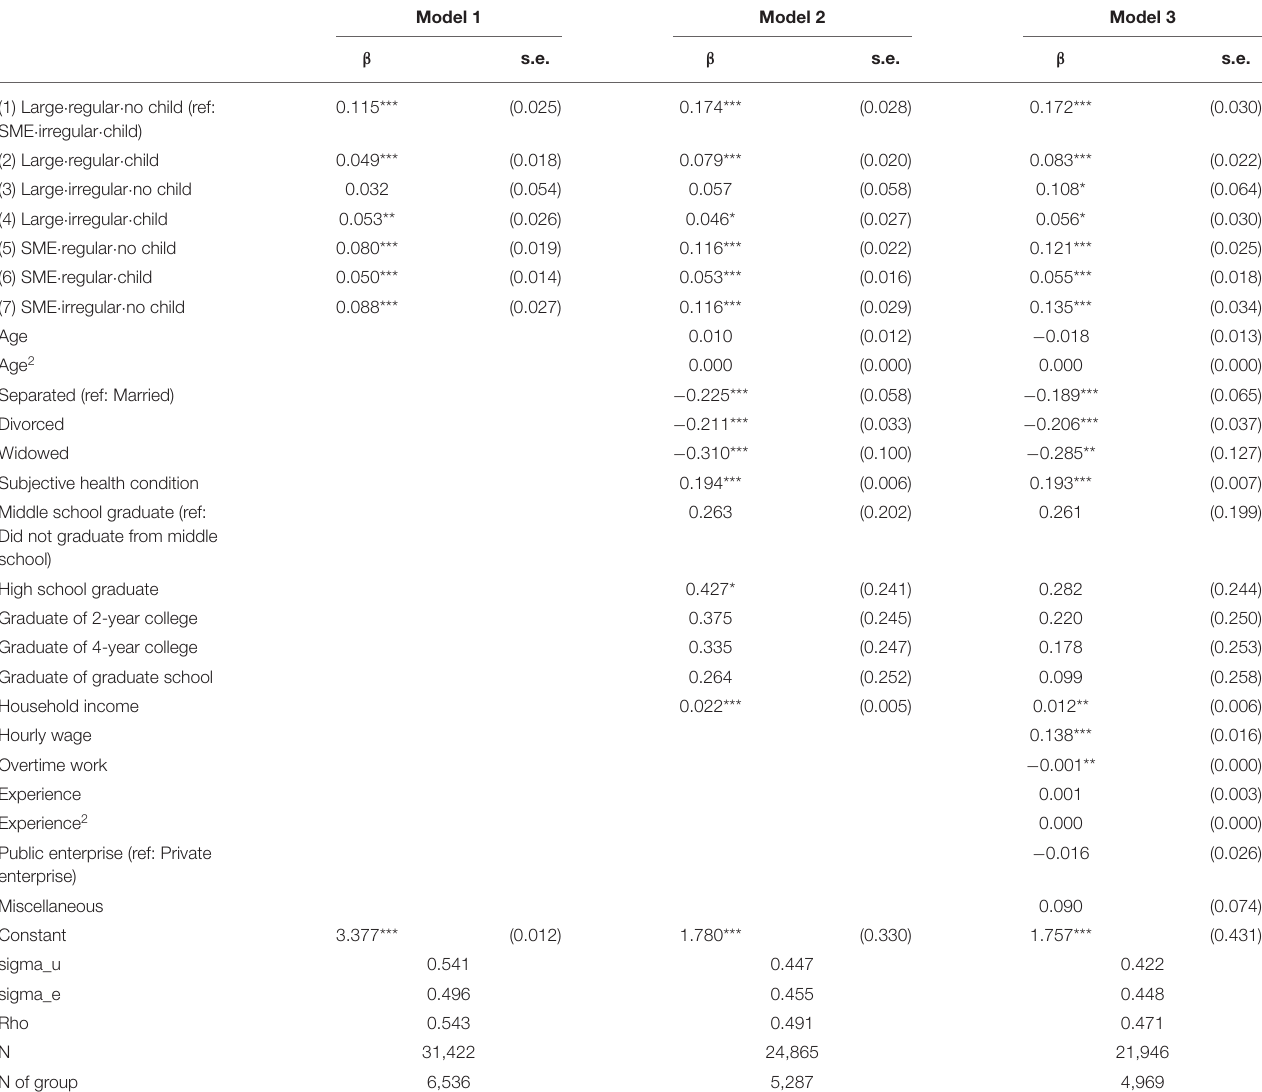
TABLE 2 | Effects of the parenthood on life satisfaction by stratified labor market group